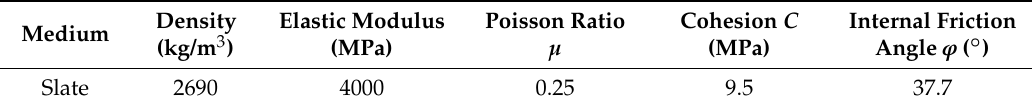
Table 3. Physical mechanical parameters of rock